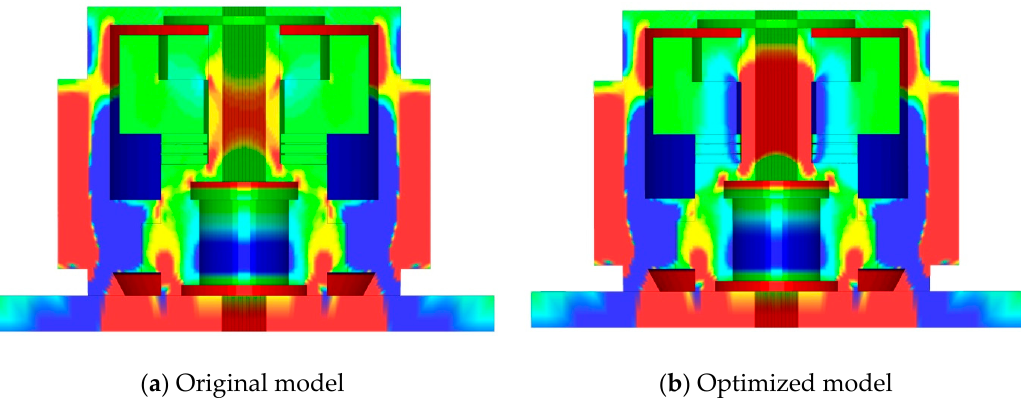
Figure 17. The contrasts of bolt stress caused by temperature of 648 °C .